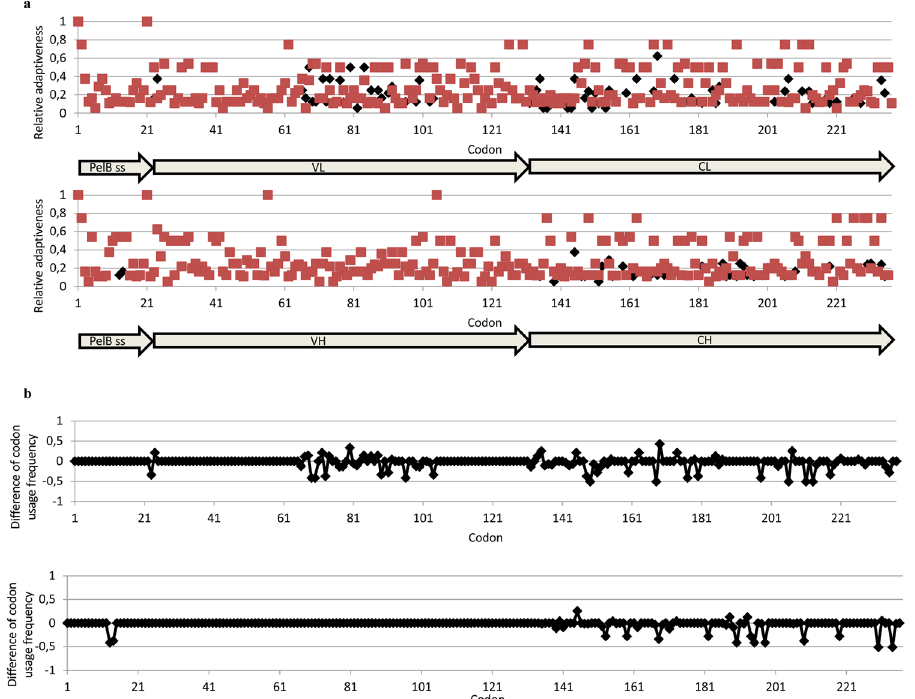
Figure 2. Codon usage of sFab and Fab0. In both figures, the light chain is represented in the upper and the heavy chain in the lower diagram. ( a ) The relative adaptiveness diagrams showing the codon usage of sFab (red) and Fab0 (black). ( b ) Diagrams showing the difference of codon usage frequency between sFab and Fab0. Peaks above zero indicate that a codon of Fab0 has higher frequency than the corresponding sFab codon and vice versa